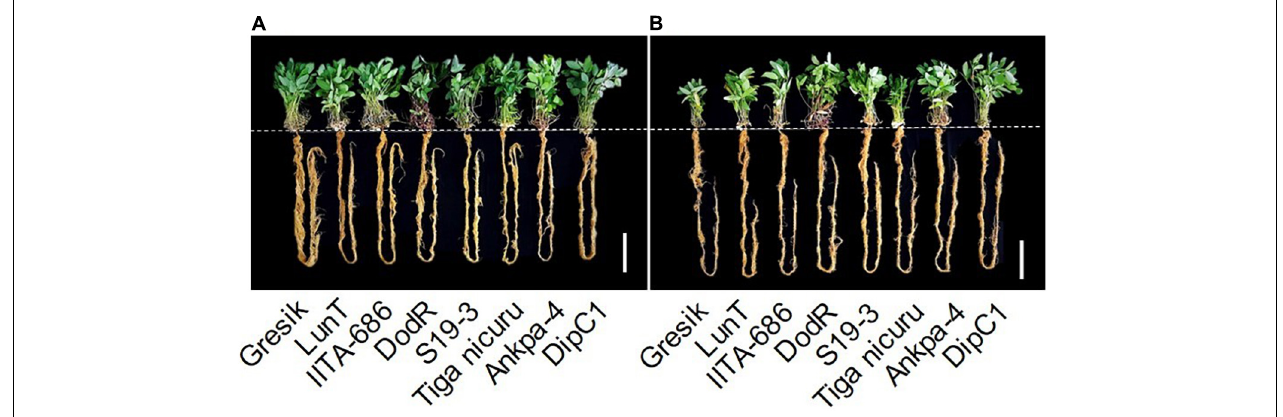
FIGURE 5 | Example images of eight bambara groundnut genotypes grown in soil-filled PVC columns in a rainout shelter under (A) WW and (B) DS treatment at 55 DAE during 2019. White bar = 15 cm.